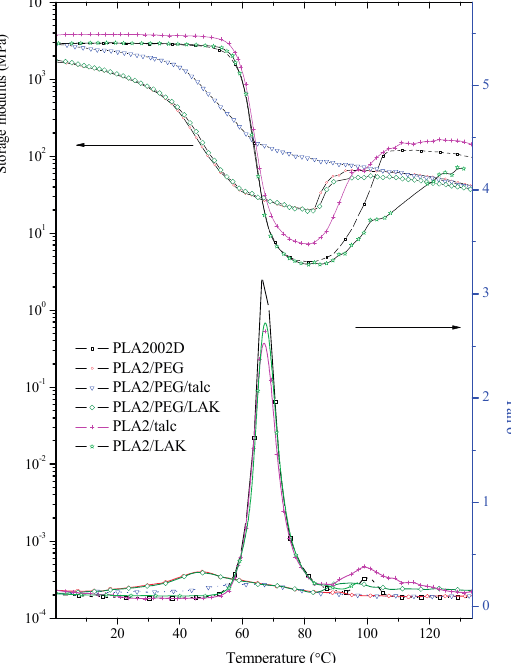
Figure 4. Temperature dependence of the storage modulus and Tan δ of selected PLA2